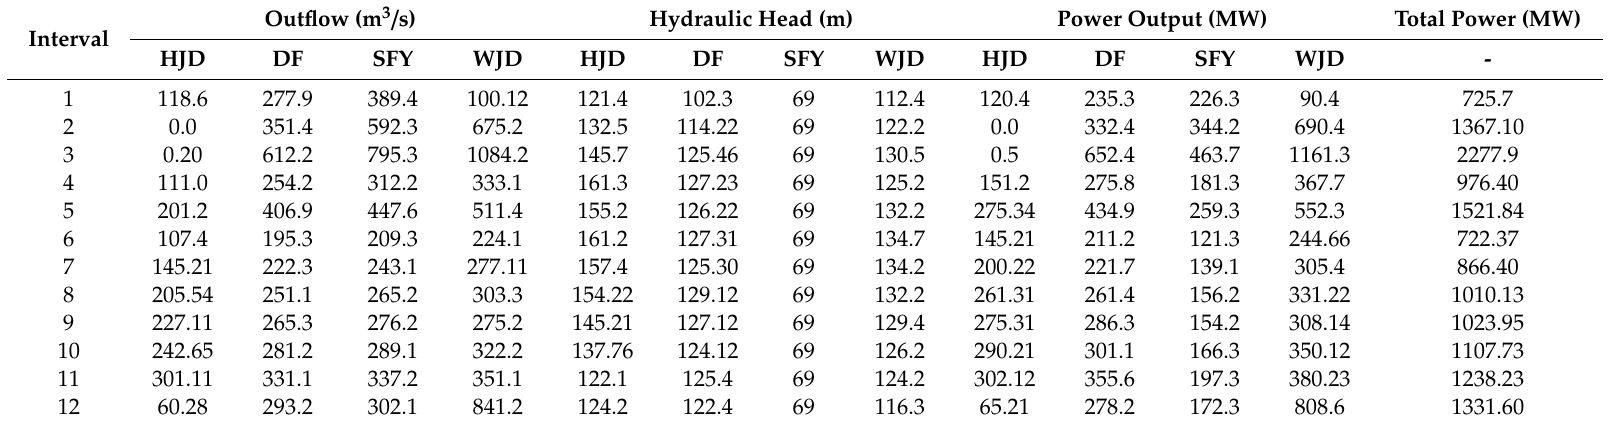
Table 6. Outflow, hydraulic head, and power output, optimized by CA, for the studied